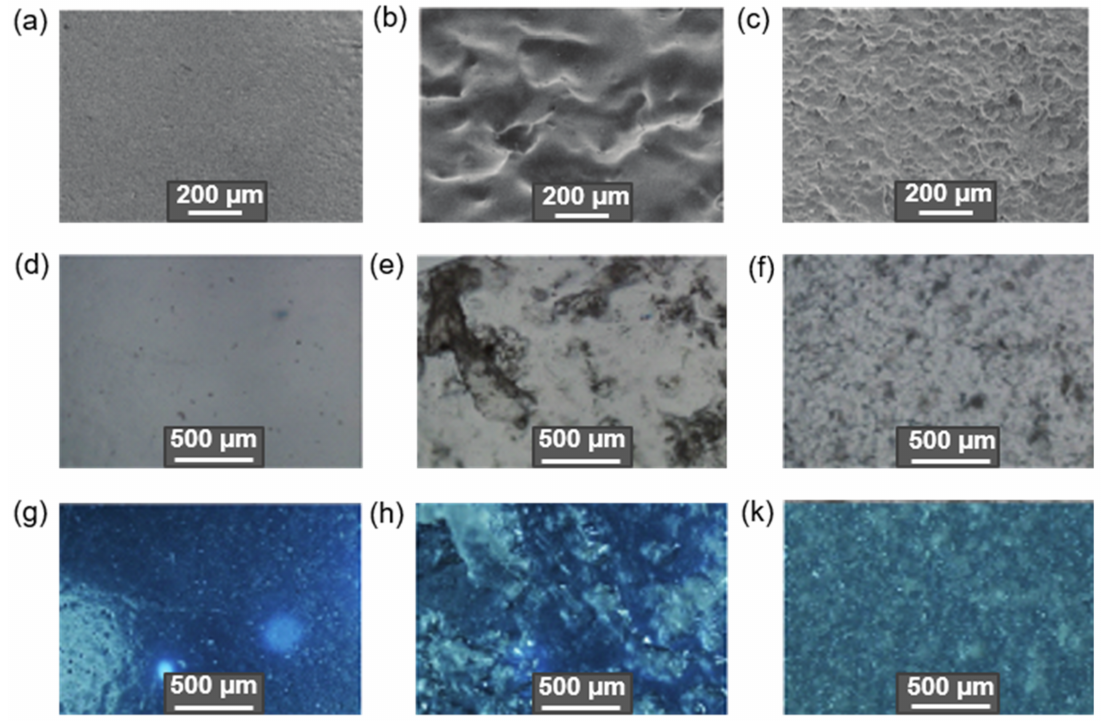
Figure 17. Images obtained by SEM ( a – c ), optical (gray) ( d – f ) and reflected (blue) ( g – k ) microscopy for pure PLLA ( a , d , g ), and its composites with neat CNC (15 wt%) ( b , e , h ), and CNC modified with poly(glutamic acid) (15 wt%) ( c , f , k ) (reproduced from [230] under the terms of the Creative Commons CC BY